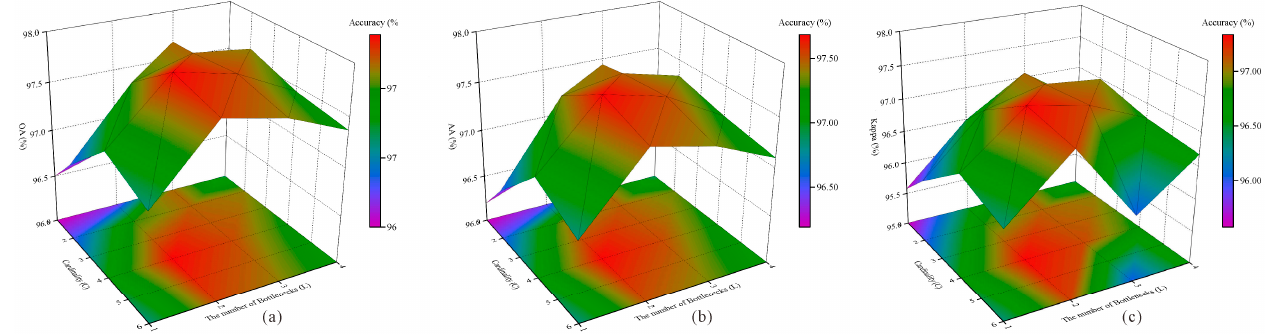
Figure 6. The performance of SSAAE on different numbers of cardinalities and bottlenecks. ( a ) OA; ( b ) AA; ( c ) Kappa.